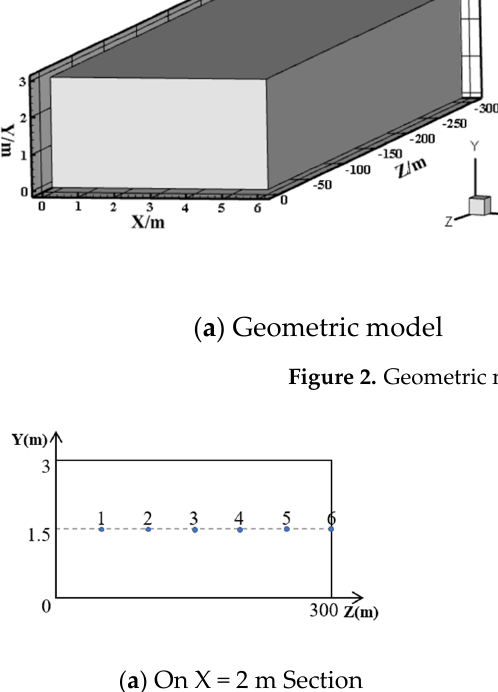
Figure 3. Distribution of measuring points.